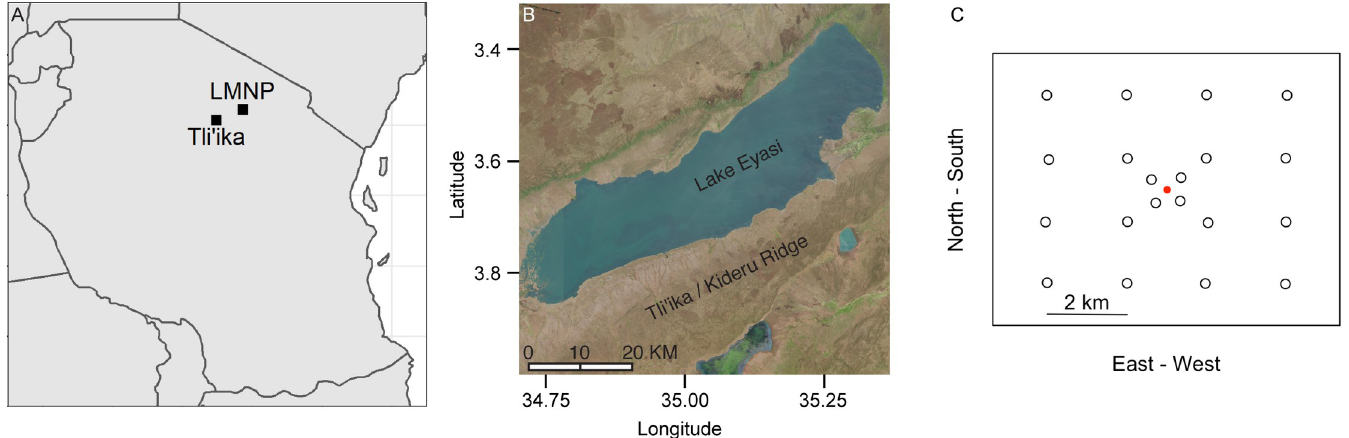
Fig 1. Map of the study area. A) Tanzania, and the location of Tli’ika and Lake Manyara National Park (LMNP); B) The region of Tli’ika in the Lake Eyasi area of northern Tanzania; C) The spatial distribution of 20 installed camera traps, centered upon the Hadza camp indicated in